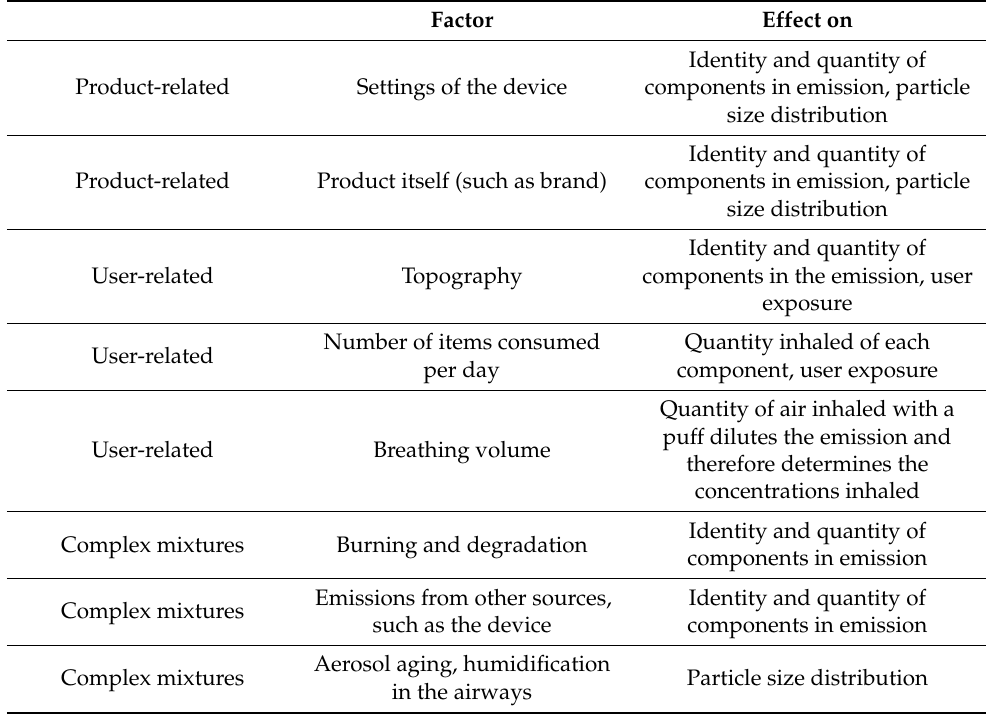
Table 2. Factors that determine exposure and deposition in the respiratory tract of TRP emissions, while using the e-cigarette as an